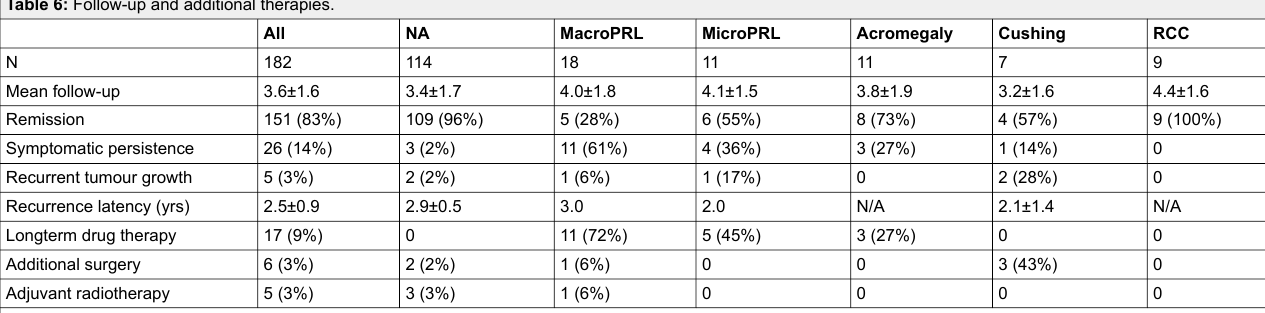
Table 6: Follow-up and additional